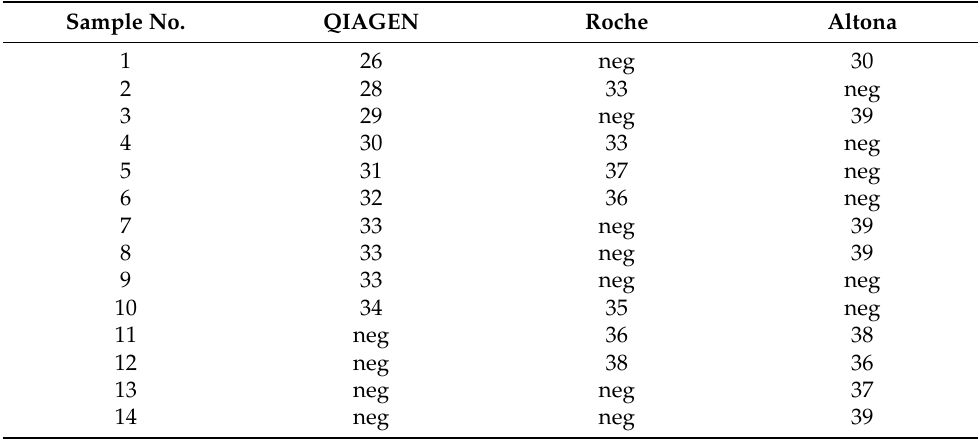
Table 2. Results of discordant samples (numbers represent Ct values obtained by different tests). Sample